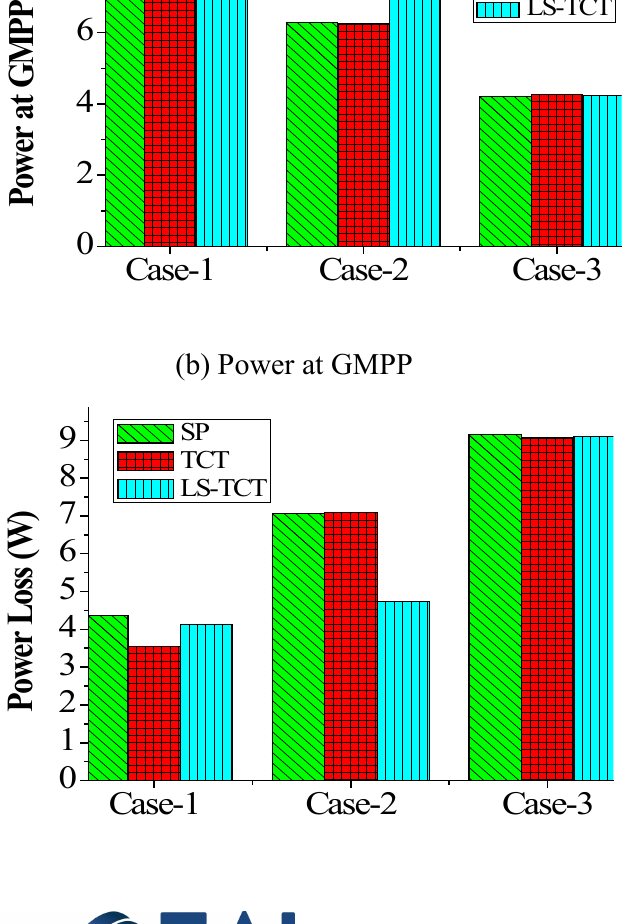
Figure 10. Comparison of performance